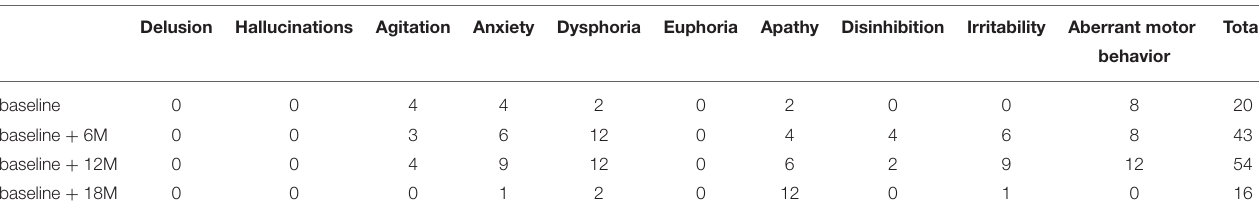
TABLE 1 | All examined items from which the NPI score was